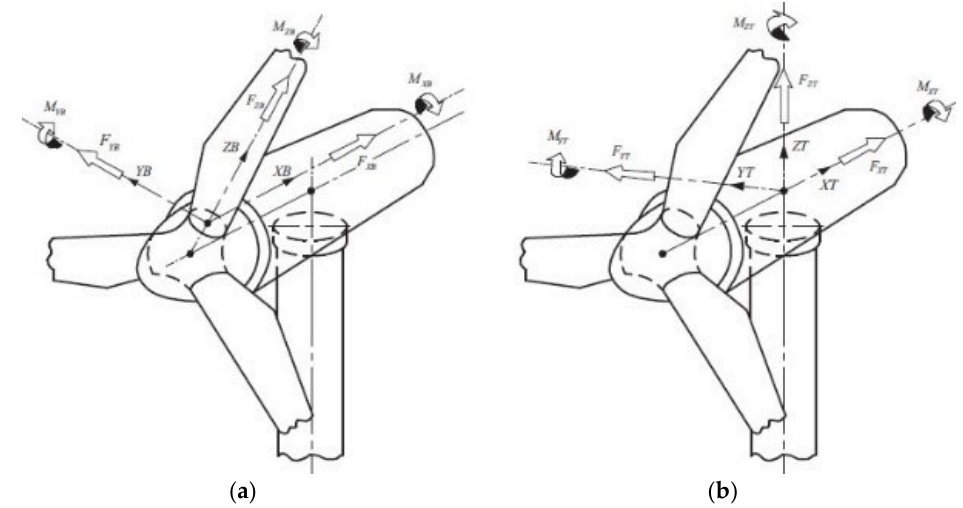
Figure 5. Wind turbine load coordinate system [16]. ( a ) Blade coordinate system. ( b ) Tower coordinate system.